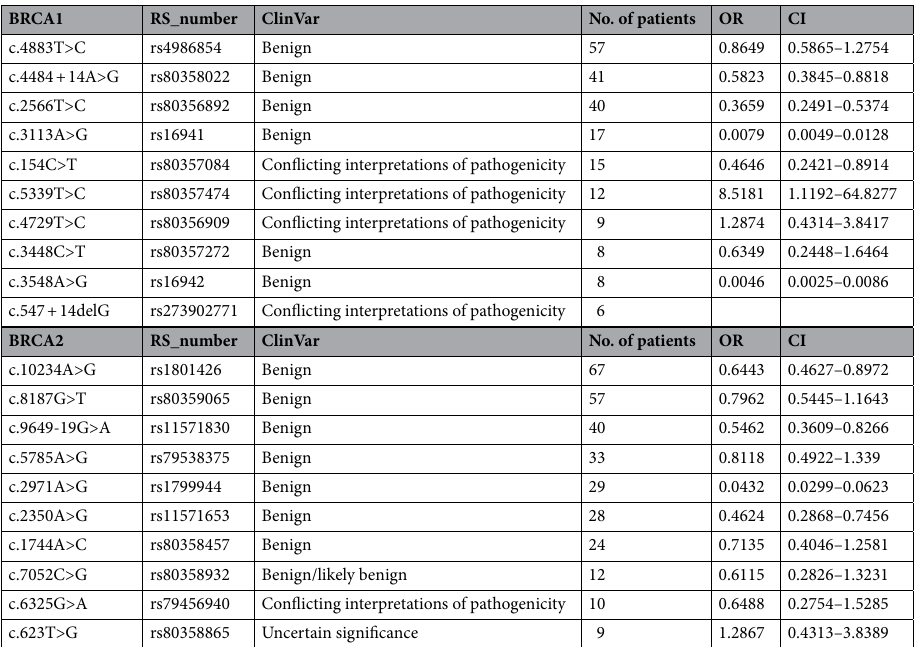
Table 2. Top 10 high-frequency mutations based on the number of